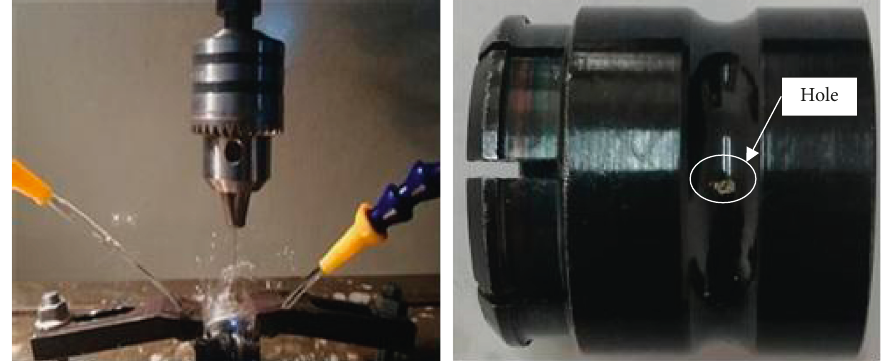
Figure 5: Bearing inner-race fault by EDM.